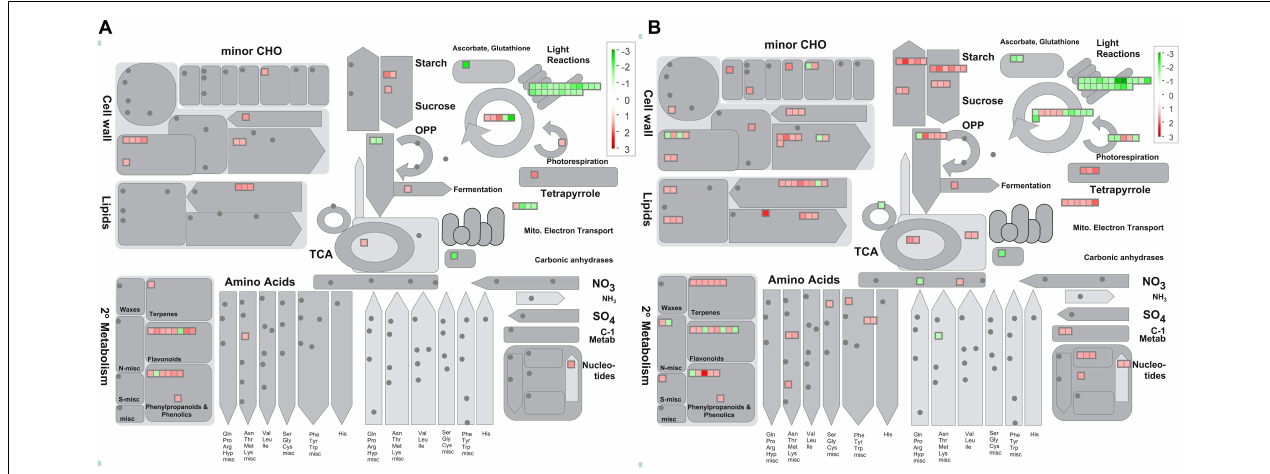
FIGURE 4 | Overview of metabolic pathways that are regulated by Ca. L. asiaticus infection in leaf petioles. (A) Asymptomatic stage (CI1 vs. MI1) and (B) symptomatic stage (CI2 vs. MI2). Red squares, significantly upregulated proteins; green squares, significantly upregulated proteins. Each colored square represents a single annotated gene in a particular